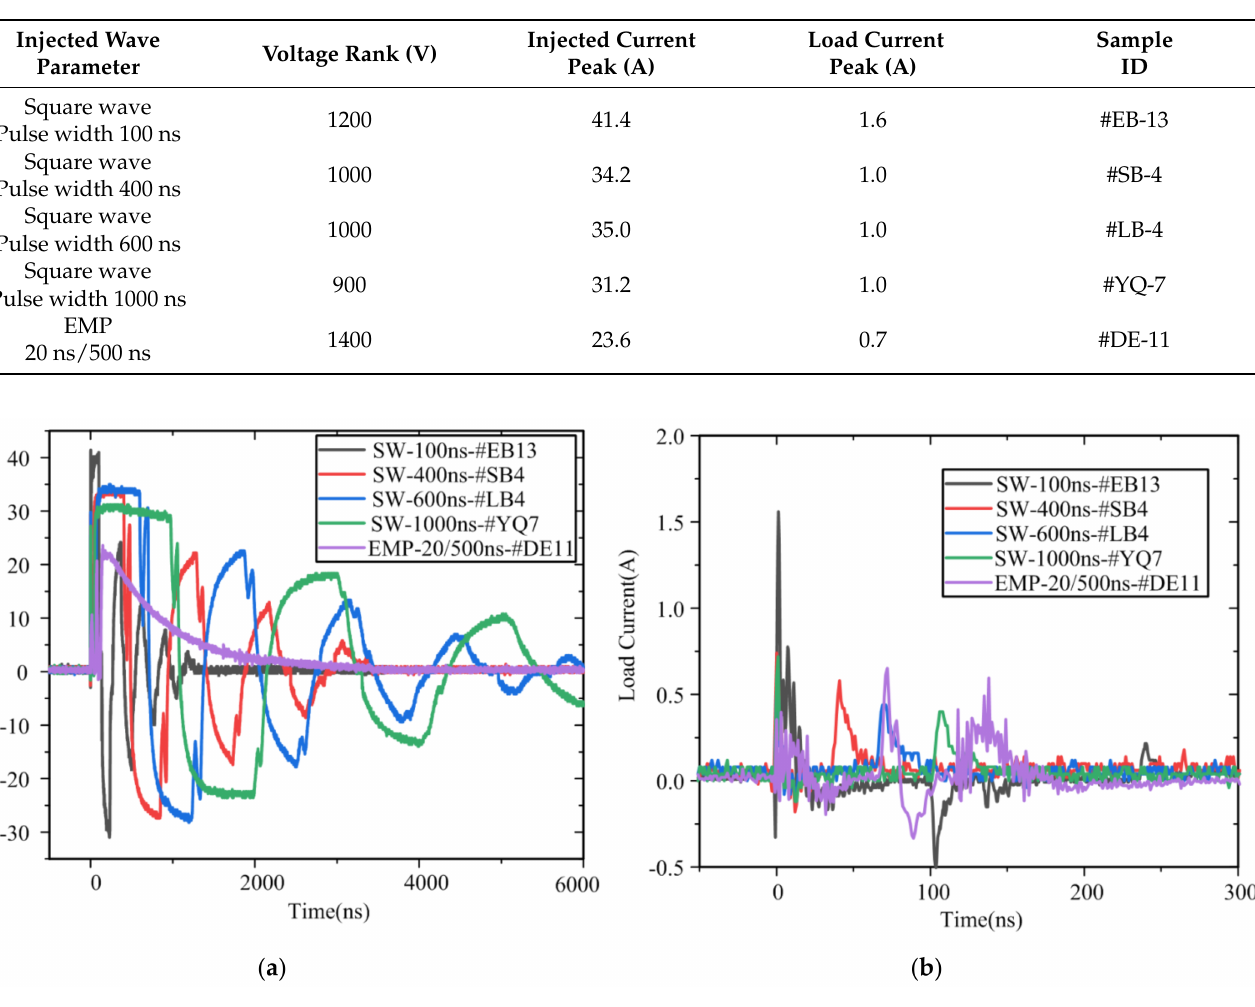
Table 1. Measured data for PCI test.